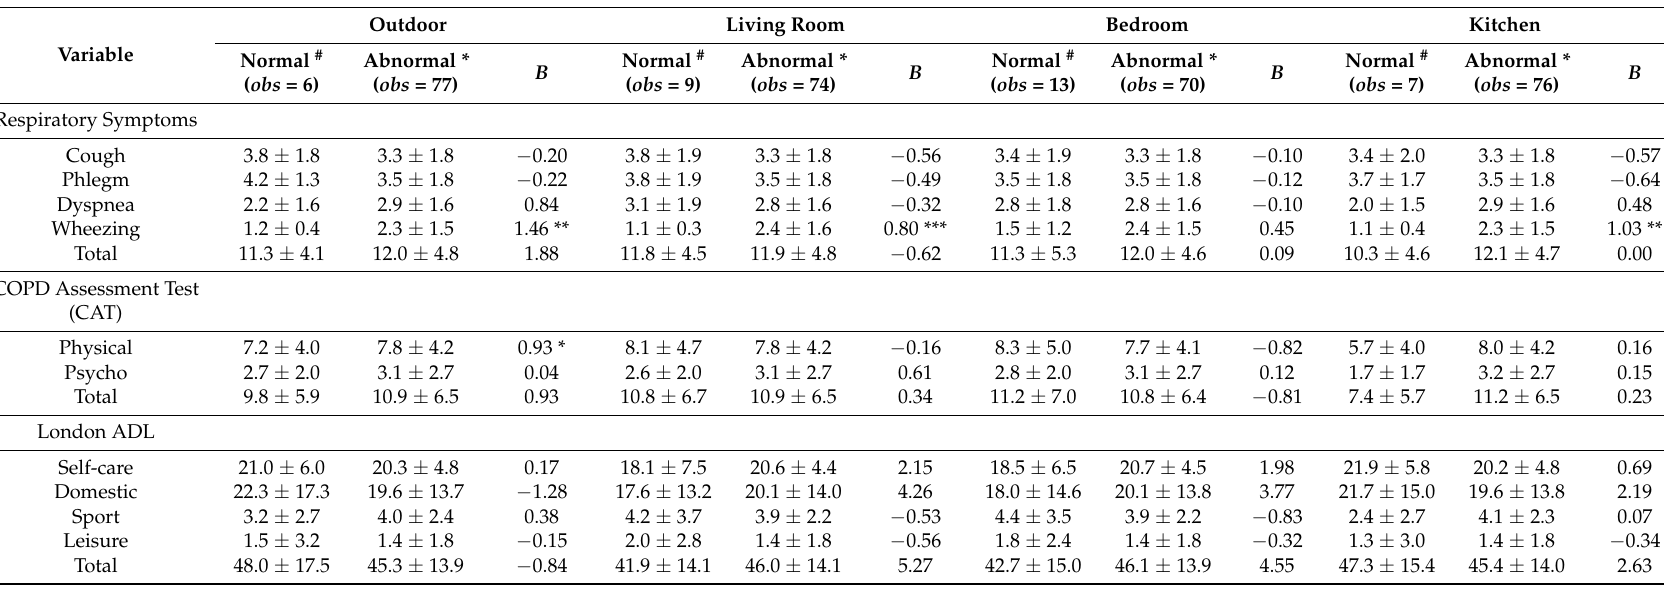
Table 2. Association between PM 2.5 level and the symptoms and activities of daily living (ADL) of chronic obstructive pulmonary disease (COPD) patients. Outdoor Living Room Bedroom Kitchen Variable Respiratory Symptoms